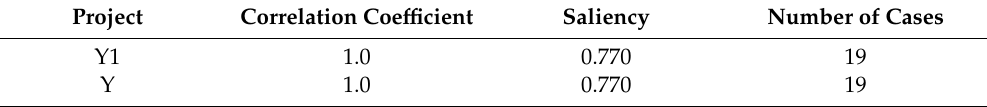
Table 6. Predicted results of the linear regression